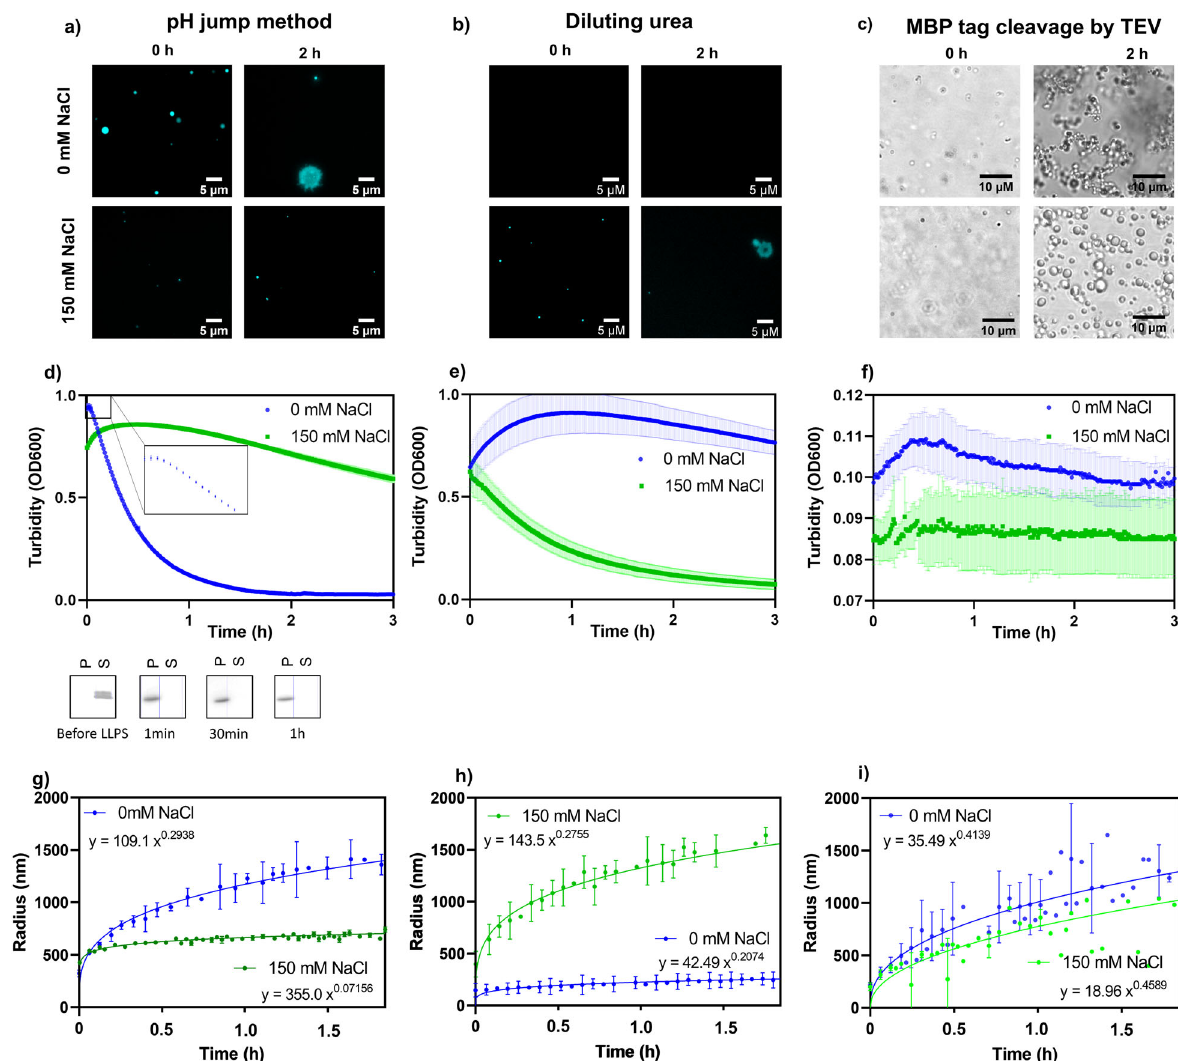
Fig. 1 Kinetics of phase separation of hnRNPA2 LCD induced by three different approaches. LLPS of hnRNPA2 LCD (at a fi nal concentration = 20 μ M) was initiated by three principally different approaches that result in very different kinetic trajectories: (1) pH jump from pH = 11.0 to 7.5 (panels a , d , and g ), (2) ×100 dilution from an 8M-urea solution resulting in a fi nal concentration of 80 mM urea ( b , e , and h ), and (3) cleavage of the His-tagged MBP of an hnRNPA2 LCD-MBP fusion construct by TEV protease ( c , f , and i ). LLPS was monitored over time in the absence and presence of 150 mM NaCl, by three different methods (where t = 0 corresponds to the addition of concentrated low-pH buffer in the pH jump, dilution by a large volume of buffer in the urea- dilution experiment and addition of a small volume of concentrated TEV solution for cleavage of MBP tag). First, droplets were visualized by fl uorescence microscopy using Dylight 488-labeled LCD (mixed into ×200 excess of non-labeled LCD) by pH jump ( a ) and urea dilution ( b ) immediately after initiating LLPS (marked 0 h) and after 2 h of incubation, in the absence and presence of 150 mM NaCl. Upon TEV cleavage ( c ), we had to use phase-contrast microscopy, as the MBP tag precluded speci fi c labeling of the LCD segment of the construct. Turbidity at 600 nm (OD600) was measured ( d , e , and f ) without NaCl (blue lines) and with 150 mM NaCl (green lines). An inset in ( d ) shows the initial 15 min of the reaction, whereas gel images below the panel show that the protein is in solution (S) before LLPS whereas it is in the pellet (P) at the different times indicated after phase separation. The size evolution of droplets formed was followed by DLS ( g , h , and i ), in the absence of NaCl (blue lines), and with 150 mM NaCl (green lines, fi tting functions are indicated on the panels). Please note that DLS measurements could not be analyzed past 1.5 h, probably due to aggregation of the protein). All kinetic traces are mean ± SD of experiments in triplicate ( n =